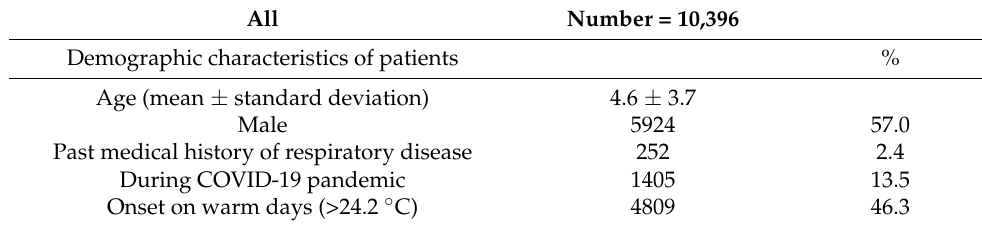
Table 1. Demographic characteristics of patients.